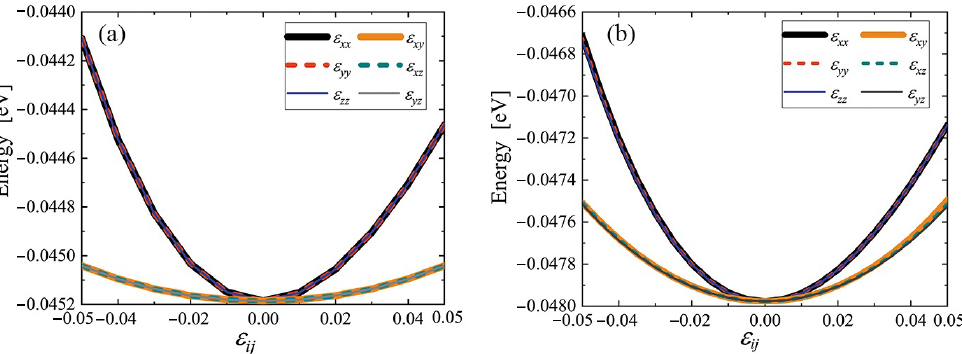
Figure 4. Potential energy per atom of cubic ( a ) and triclinic ( b ) cubene crystals depending on strain ε ij . Only one component of the strain tensor is varied, the rest are equal to zero.